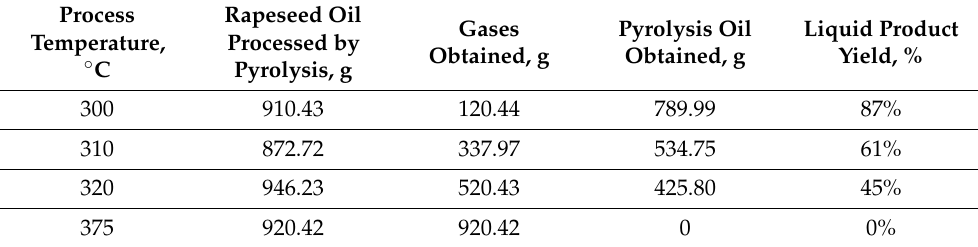
Figure 3. Process diagram for the pyrolysis under vacuum at 375 °C. Legend: pressure; batch temperature; oven temperature. Table 2. Bio-oil yields at pyrolysis under